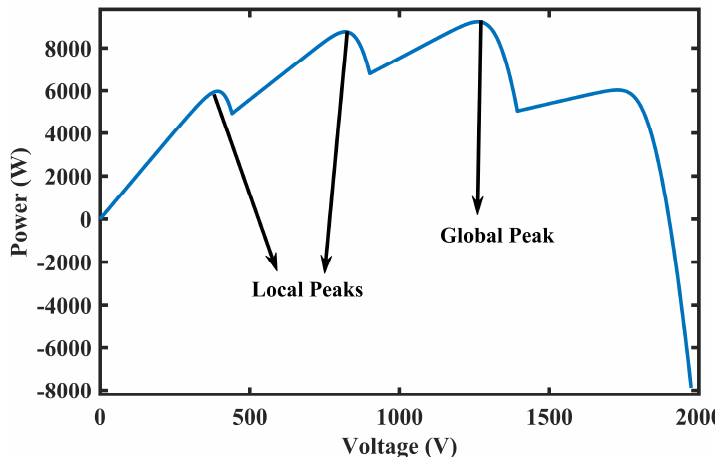
Figure 5. Global and local peaks due to the shading